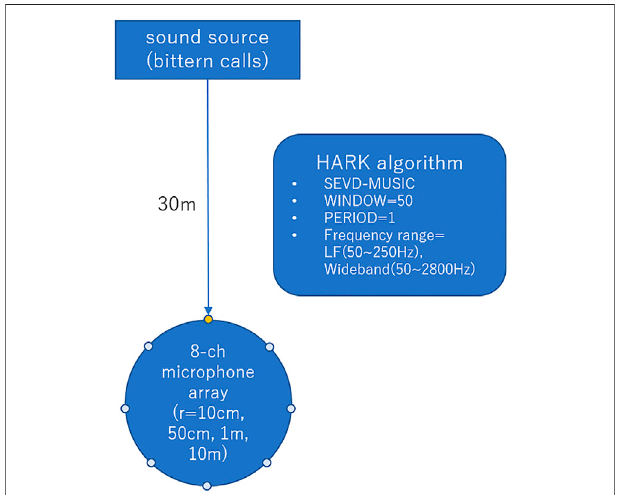
FIGURE 2 | Schematic illustration of numerical